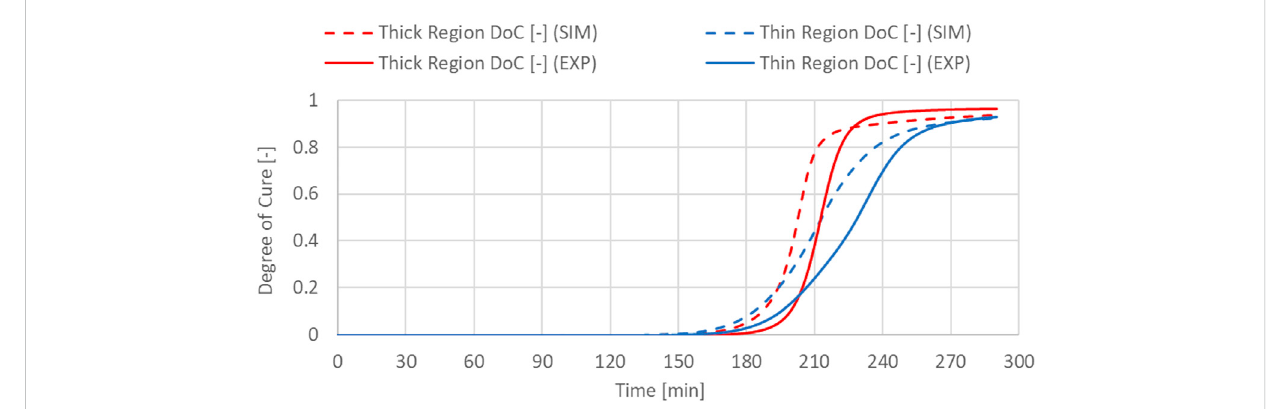
FIGURE 7 Degree of Cure calculated using simulated and measured temperature data at mid-thickness in thick and thin region for single zone cure.